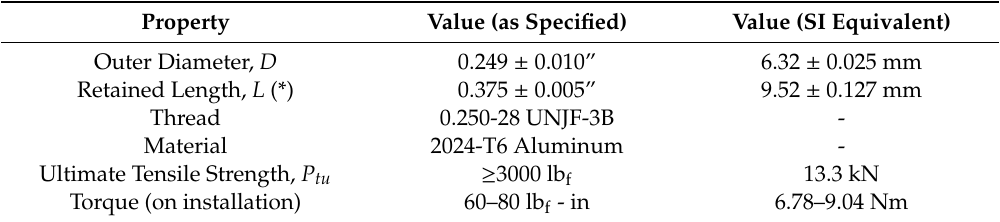
Table 2. General properties of HL70-8 collar